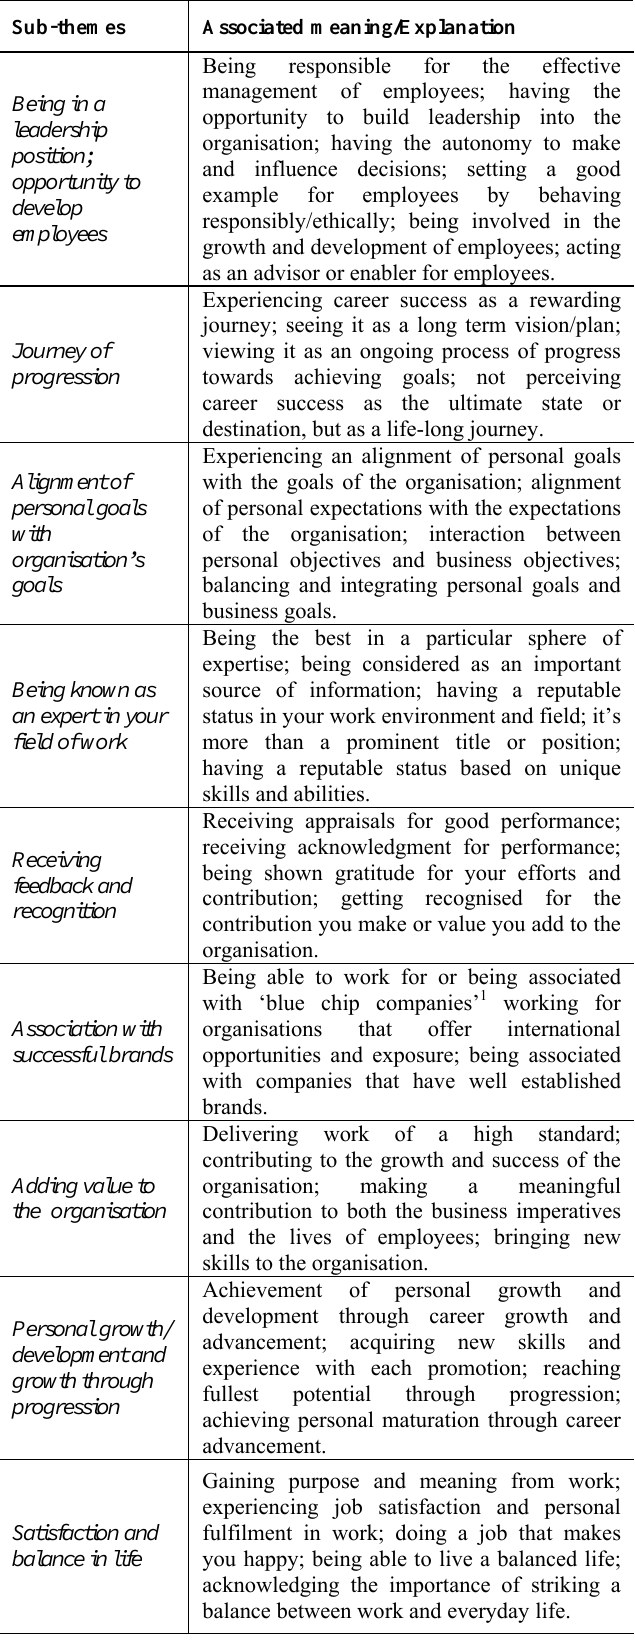
Table 2: The personal meaning senior managers